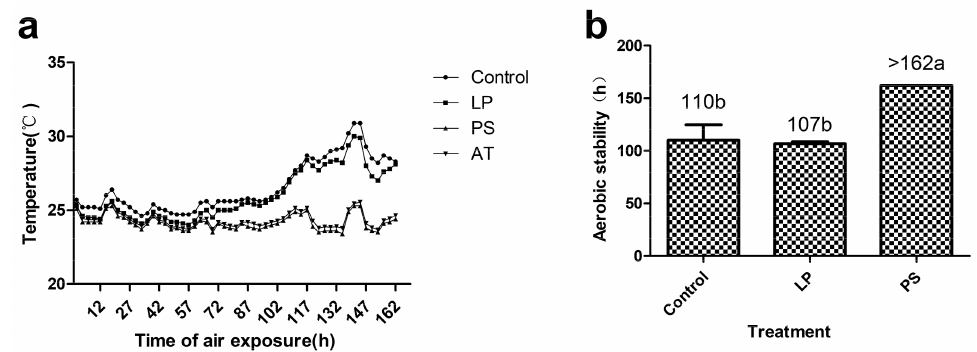
Figure 2. Dynamic changes in temperatures ( a ) and hours of aerobic stability ( b ) of TMR silages during air exposure (bars indicate standard error of the means). Values with di ff erent letters show significant di ff erences among the treatments ( p < 0.05). LP, Lactobacillus plantarum inoculant; PS, potassium sorbate; AT, ambient